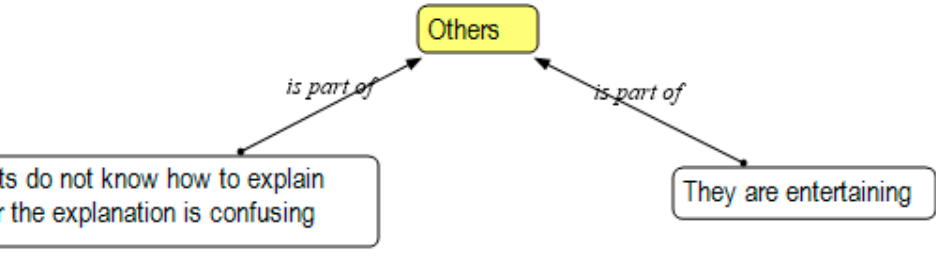
Figure 7. Category of “others”.